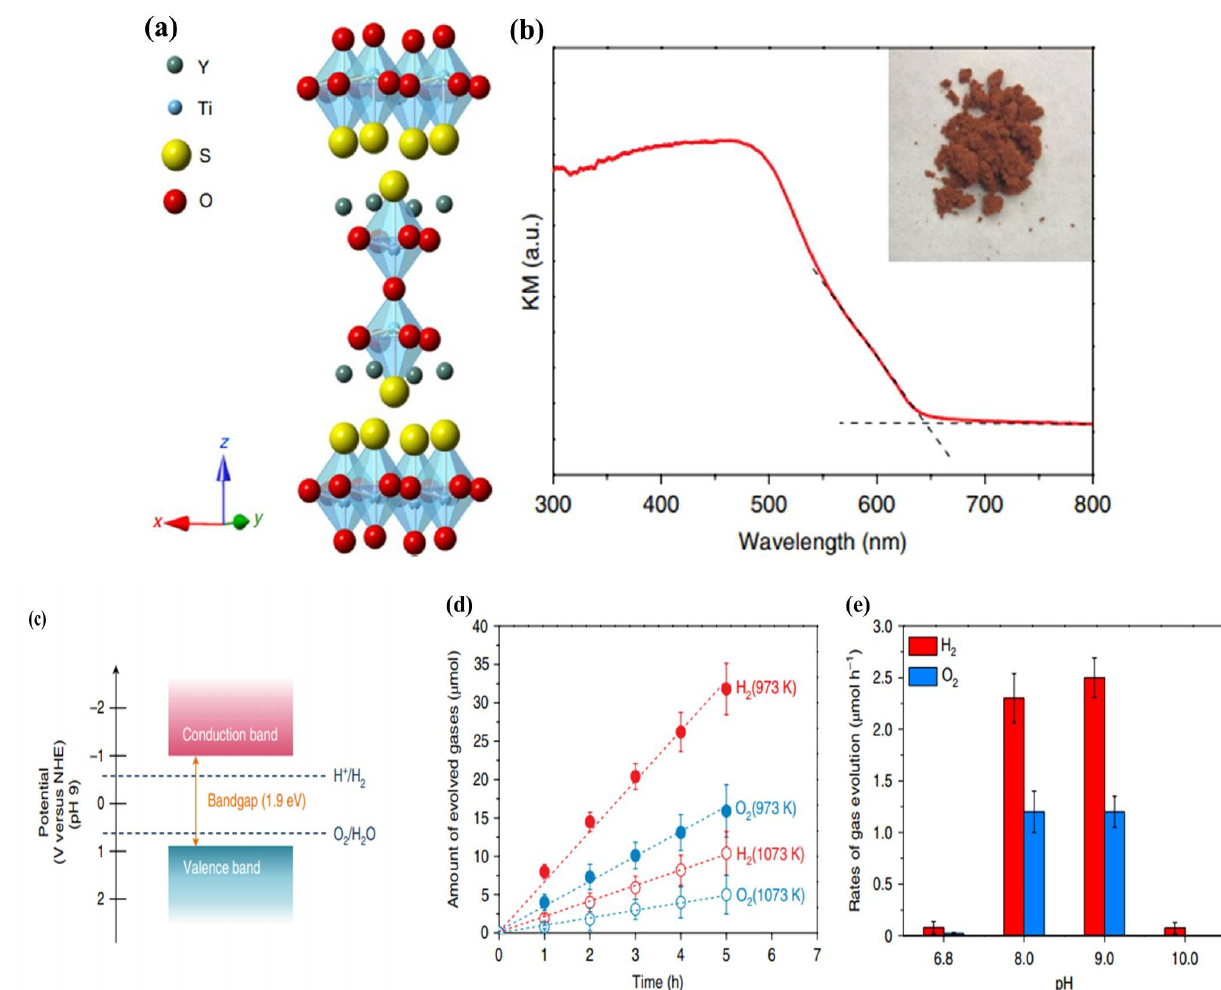
Figure 11. ( a ) Crystal structure of Y 2 Ti 2 O 5 S 2 photocatalyst; ( b ) diffuse reflectance spectra for Y 2 Ti 2 O 5 S 2 ; ( c ) band gap structure of Y 2 Ti 2 O 5 S 2 ( d ) represents the amount of hydrogen and oxygen gas produced by Cr 2 O 3 /Rh/IrO 2 -modified Y 2 Ti 2 O 5 S 2 prepared at two different temperatures in the presence of La 2 O 3 (pH8.5); and ( e ) gas evolution rates of Cr 2 O 3 /Rh/IrO 2 -modified Y 2 Ti 2 O 5 S 2 at various pH. Adapted with permission from ref. [16], Copyright 2019, Springer Nature.